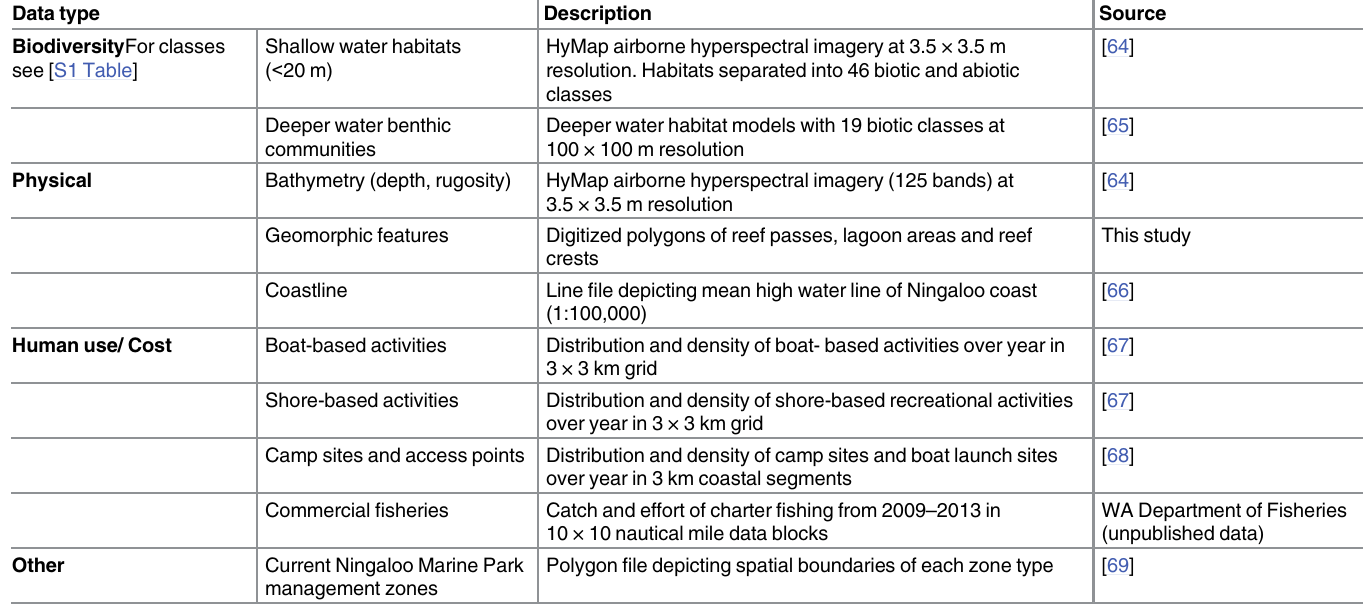
Table 2. Details of datasets used for the incremental refinement of Ningaloo Marine Park no-take sanctuary zones to accommodate resilience features. Data